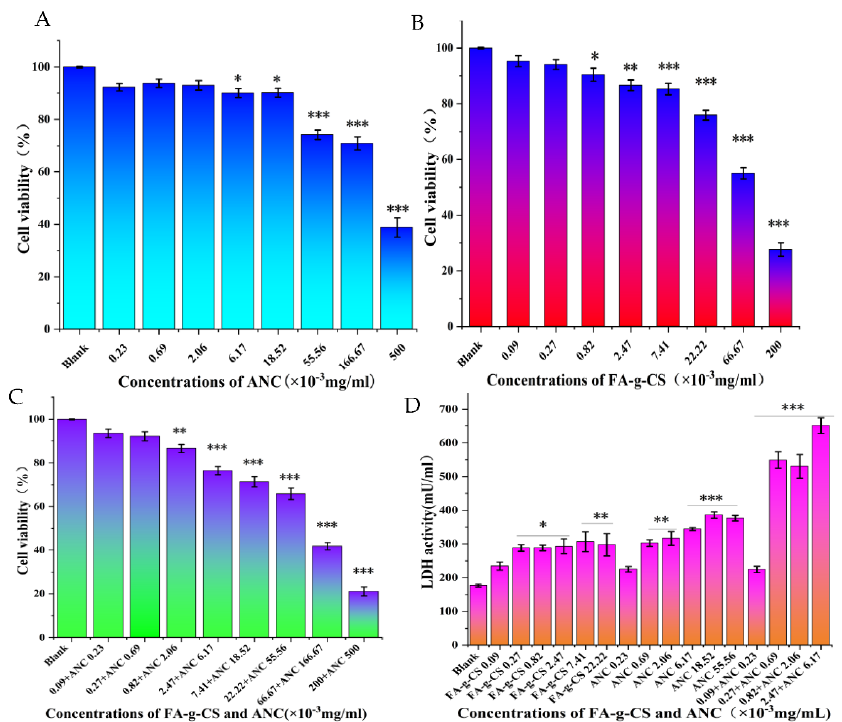
Figure 1. Cell viability of ANC ( A ), FA-g-CS ( B ), and FA-g-CS and ANC ( C ), as determined by MTT assay and LDH analysis ( D ). Asterisks indicate statistically significant differences from untreated cells (*— p < 0.05; **— p < 0.01; ***— p < 0.001). cells (*— p < 0.05; **— p < 0.01; ***— p <